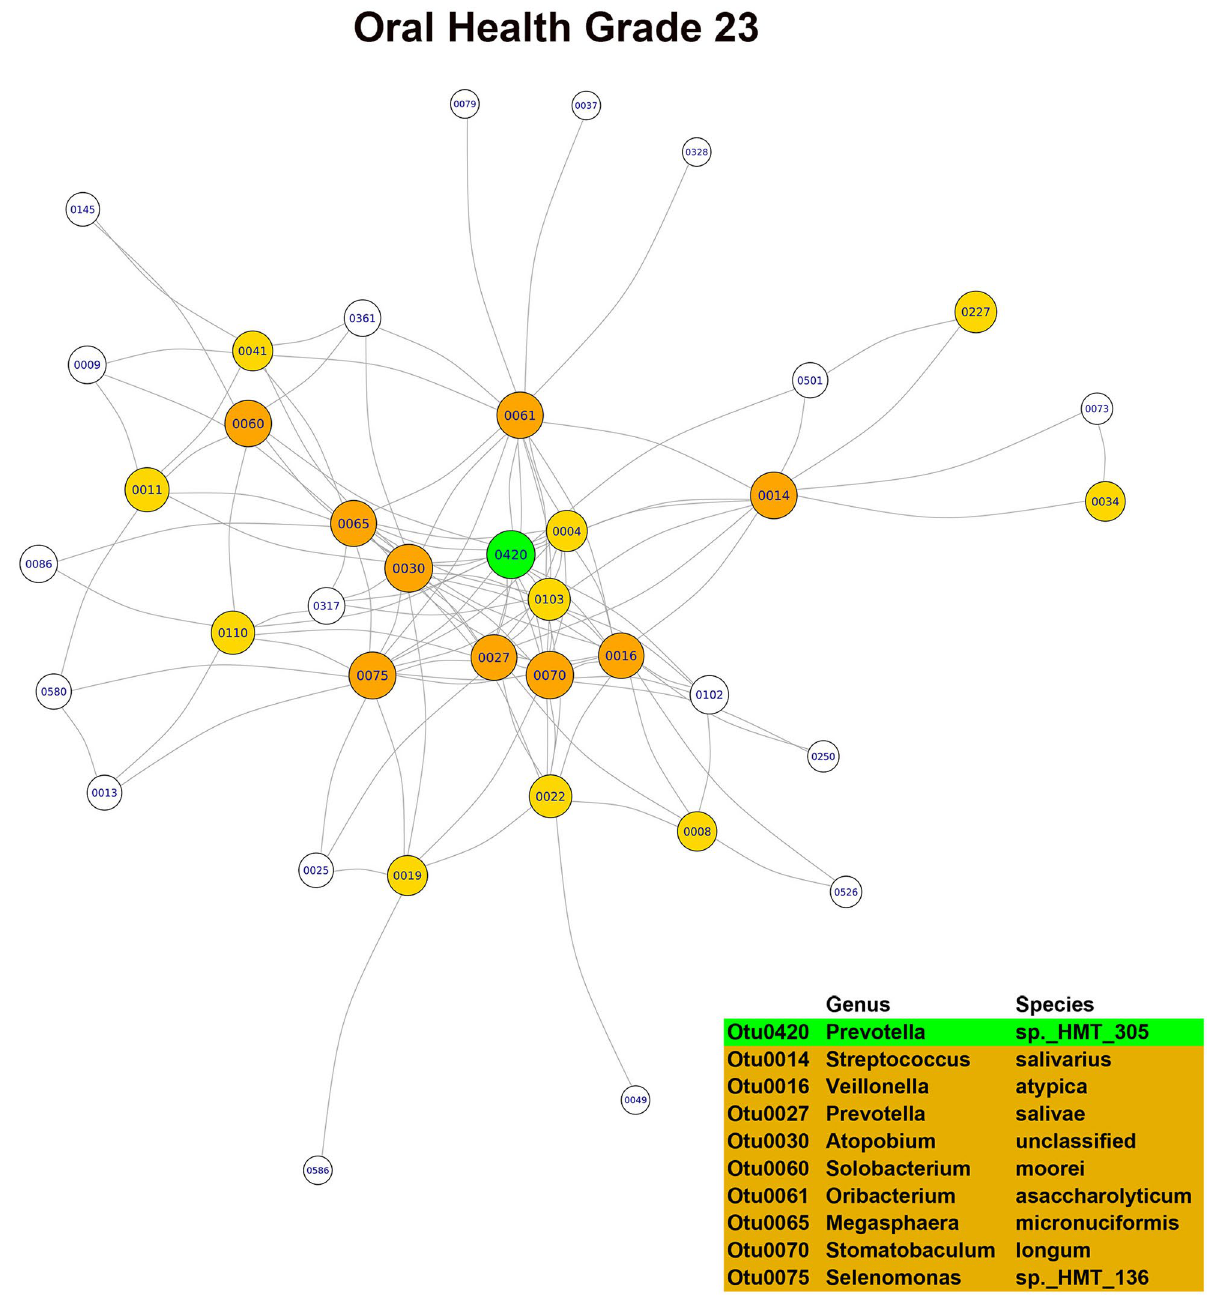
Figure 4. Main module of the co-occurrence network associated with grade 2,3 of the overall oral health scale (node = 38; degree = 280) (graphic made using the igraph package, version